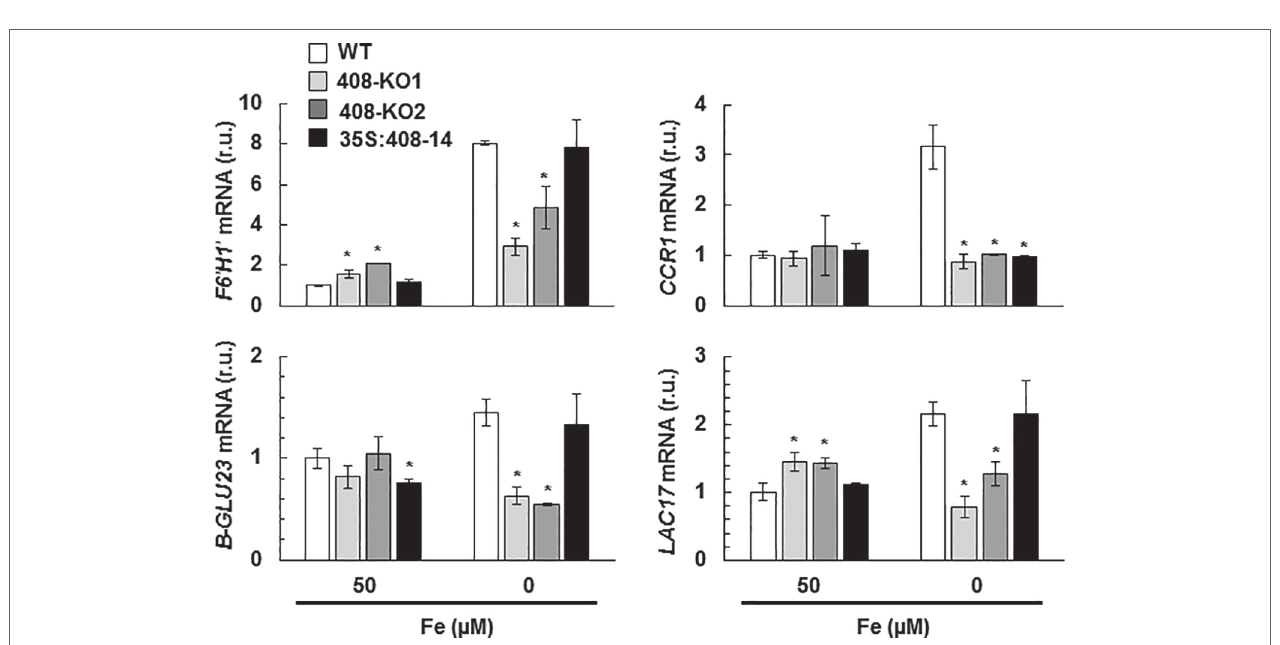
FIGURE 4 | Gene expression of the lignification-related genes under iron deficiency in the seedlings with altered miR408 expression. F6 ′ H1 ′ , B-GLU23, LAC17 , and CCR1 relative expression. The 15-day-old wild-type (WT), 408-KO1, 408-KO2, and 35S:408-14 seedlings grown in 1/2 MS medium containing 50 and 0 μ M Fe citrate. Total RNA was extracted and analyzed by RT-qPCR with specific oligonucleotides for F6 ′ H1 ′ , B-GLU23, LAC17 , and CCR1. The UBIQUITIN10 gene was used for data normalization, and the expression is shown in relative units (r.u.). Values correspond to the arithmetic means (2 −∆∆Ct ) ± standard deviation of at least three biological replicates ( n ≥ 3). Asterisks depict significant differences for the same group of samples versus the WT line ( p < 0.05) based on the pair-wise fixed reallocation randomization